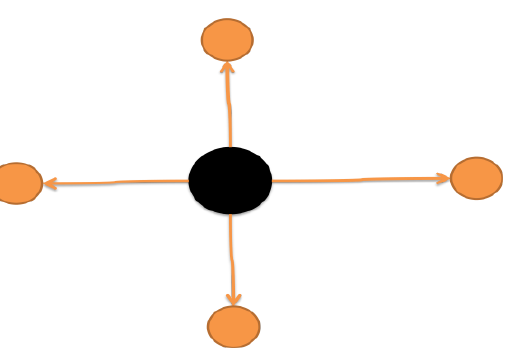
Figure 8. Illustration of a splitting